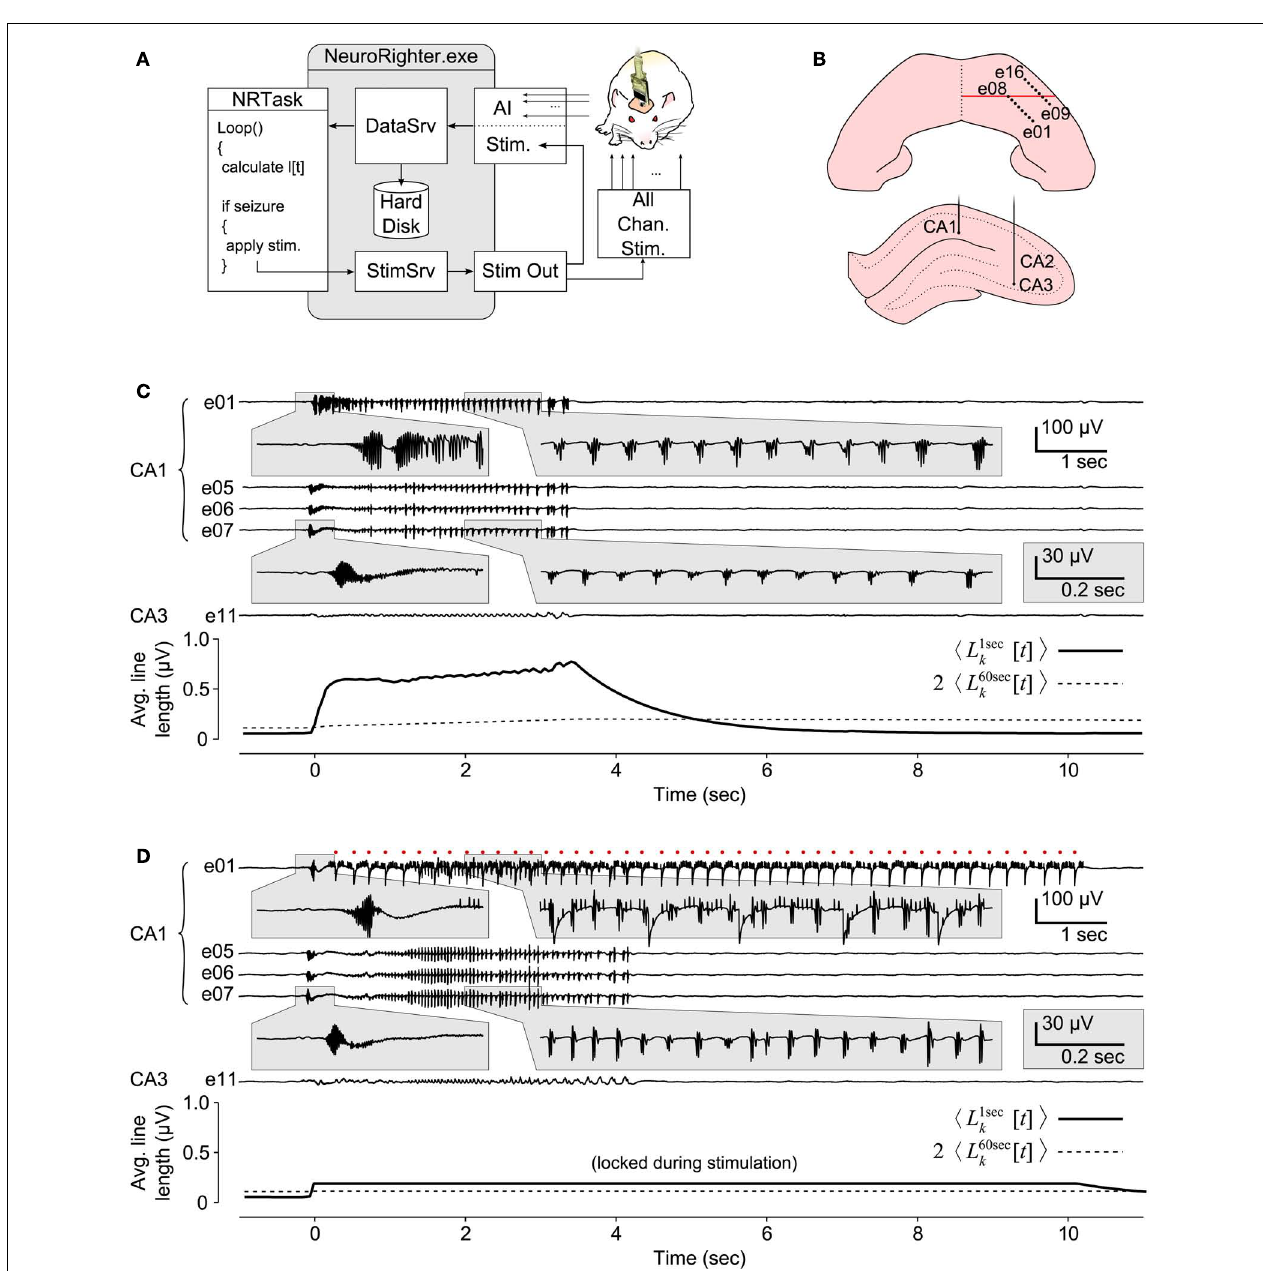
the coronal view shown below. (C) A 12s epoch of hippocampal LFPs during a seizure event. Electrodes 1–8 were located in CA1 and 9-16 in CA3.The line length measures, averaged across channels, are shown below the LFP traces. Seizure detection occurs at 0s. (D) Same as (C) except with closed-loop stimulation engaged. Electrical stimulation was applied on electrode 1 along with nine other electrodes (not shown). Red dots indicate stimulation times for e01 and stimulation artifacts appear on the LFP trace. e05–e07 and e11 were not used for stimulus